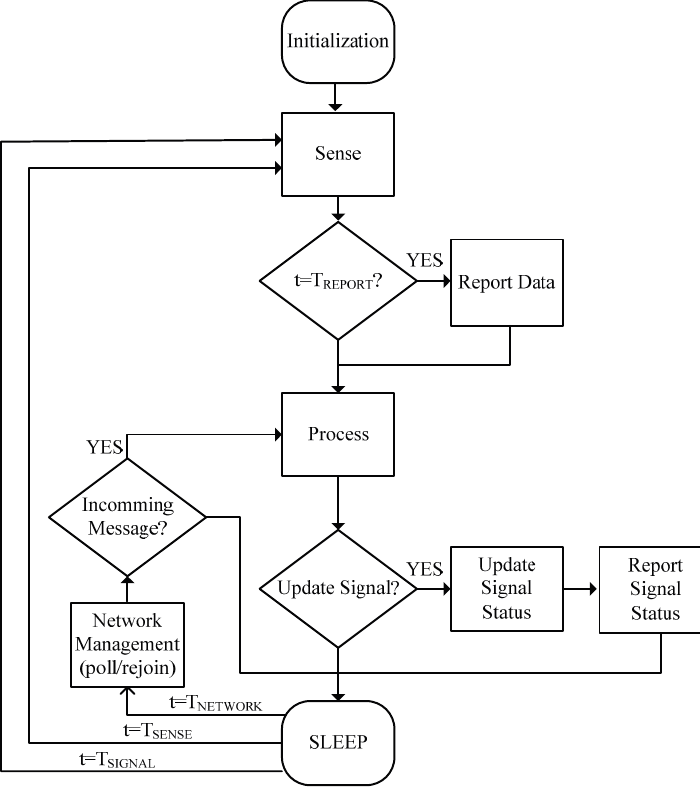
Figure 2. Operation cycle of Smart